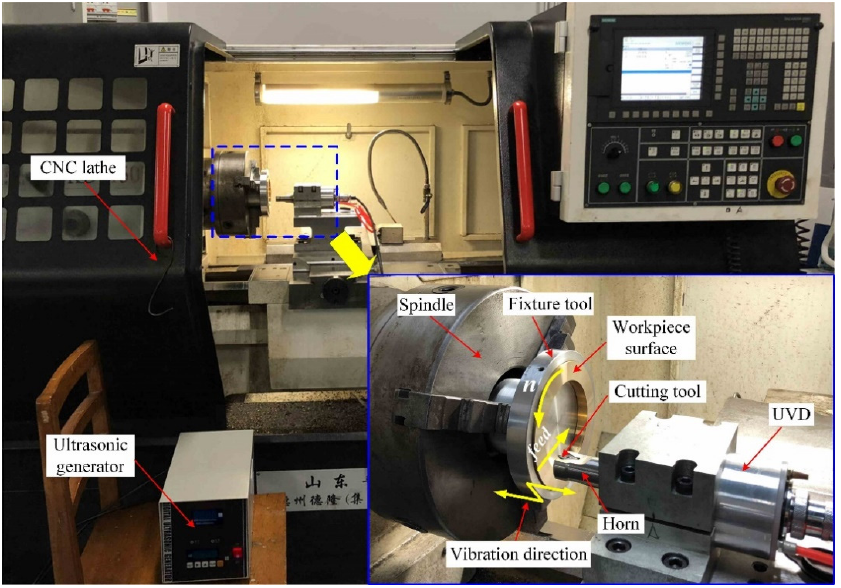
Figure 2. Experimental setup for generating the micro-textured surface of a brass H62 workpiece. Referring to previous research results, the optimized combination of processing pa- rameters (from entry #1 to entry #4) used for fabricating the specific four micro-textured surfaces are summarized in Table 1. For the convenience of the subsequent analysis and description, the micro-textured surfaces corresponding the processing parameters of entries #1, #2, #3, and #4 are respectively defined as surface #1, surface #2, surface #3, and surface #4 in turn. As an experimental comparison, two other surfaces were also prepared. One is a surface fabricated by the turning on the same experimental platform without ultrasonic vibration, and the corresponding processing parameters were listed in entry #5 of Table